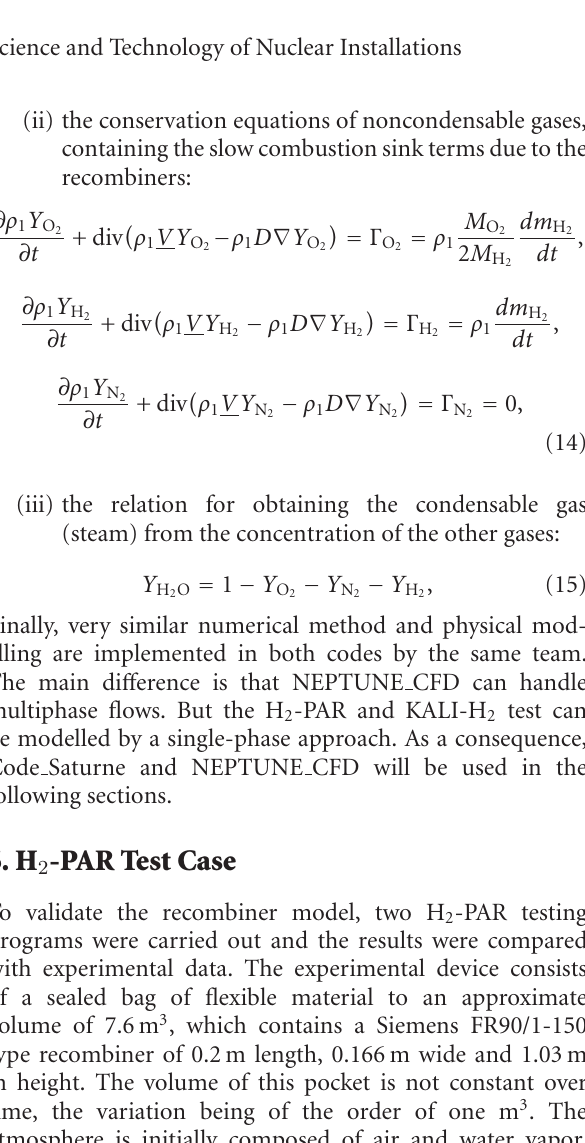
Figure 3: H 2 -PAR test: computational domain.